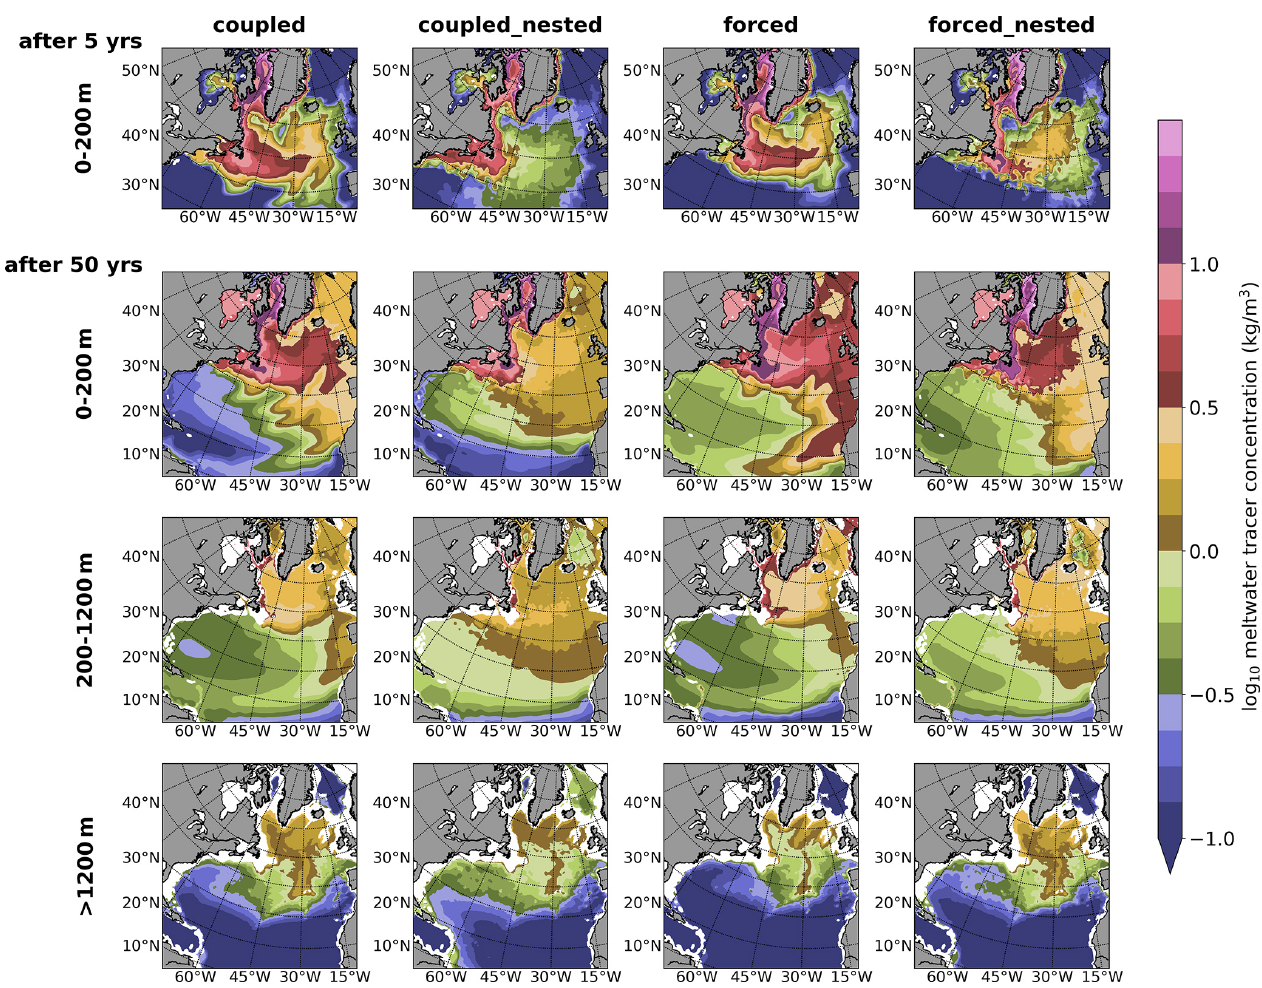
Figure 13. Snapshots (5d mean) of meltwater passive-tracer concentration 5 years (top row) and 50 years (lower three rows) into the perturbation experiments. For the later period, the average concentration for three depth layers is shown: upper (0–200m), middle (200– 1200m), and deep ocean (below